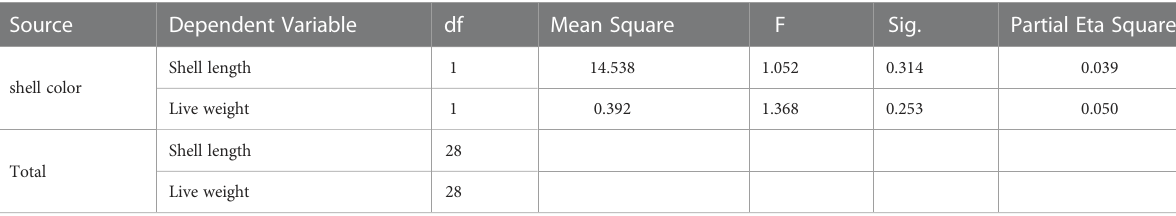
TABLE 1 Results of the multivariate analysis of variance (MANOVA) showing the difference of live weight and shell length of C. Tritonis with different shell colors.